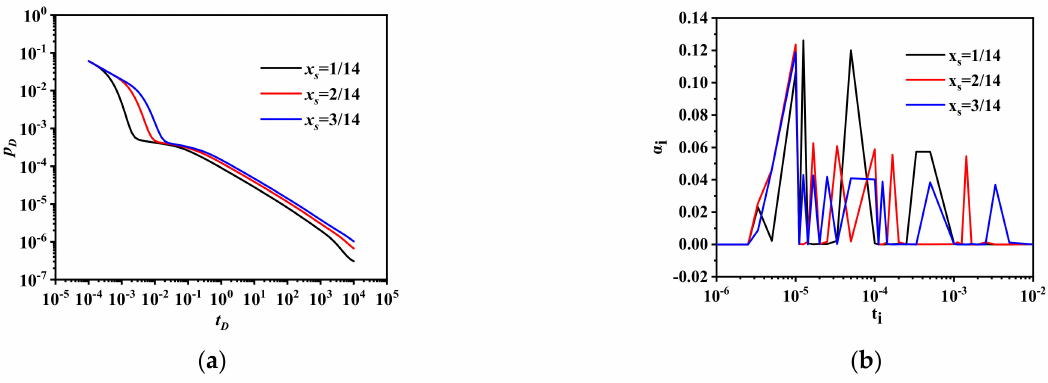
Figure 4. Effect of x s on well rate. ( a ) Dimensionless well rate. ( b ) Time scale